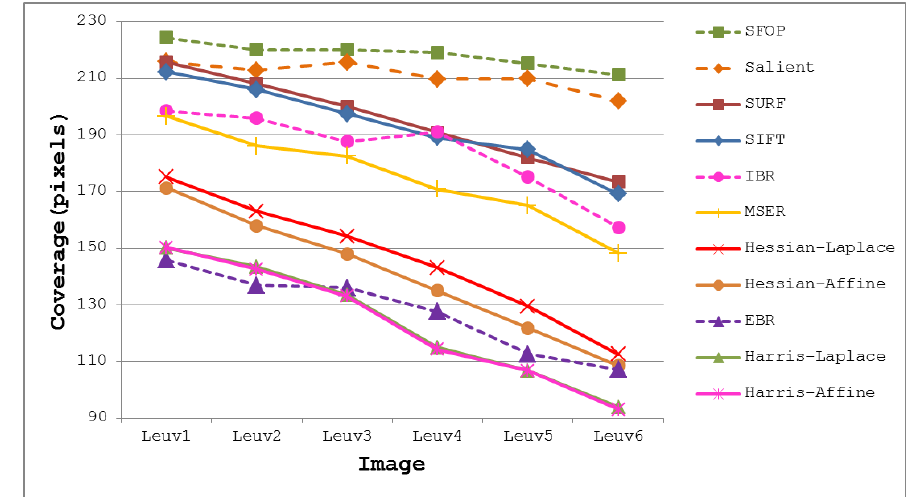
Figure 2. Coverage results for the Leuven dataset [21].